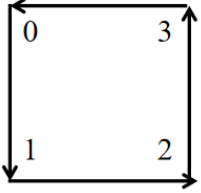
Figure 1. A connected directed unweighted graph.